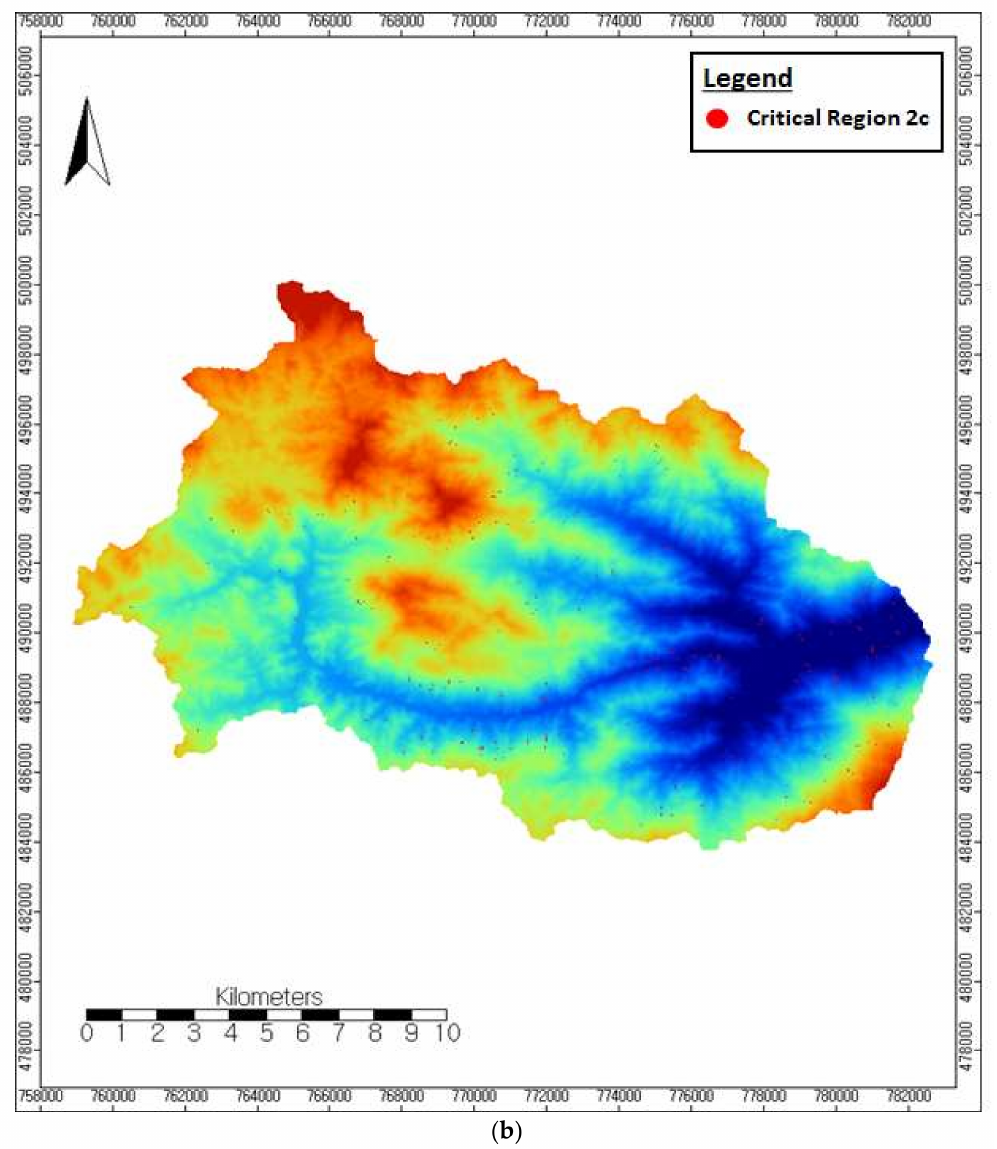
Figure 7. Distribution of stability domains for the Susu River Basin, categorized by shear stress: ( a ) characteristic regimes; ( b ) critical regimes: Region